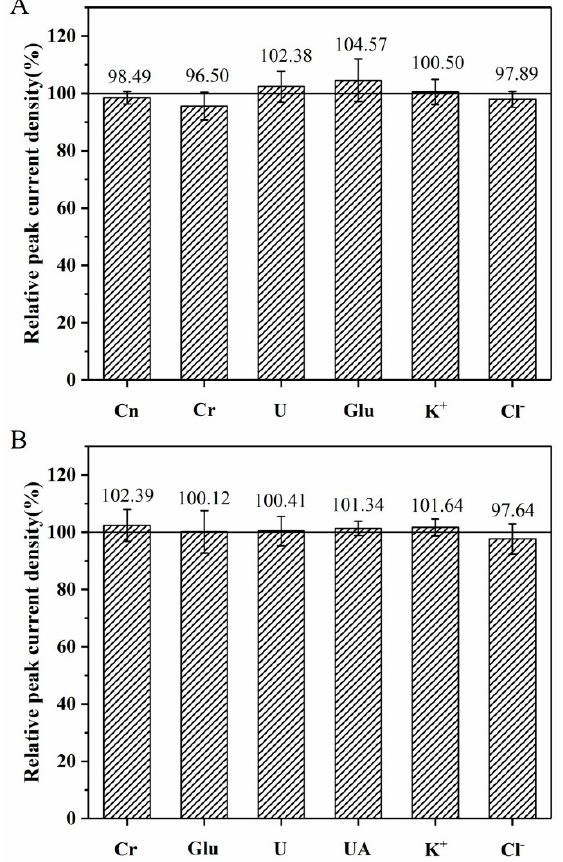
Figure 6. Influence of common compounds and ions in urine on determination of uric acid ( A ) and creatinine ( B ).